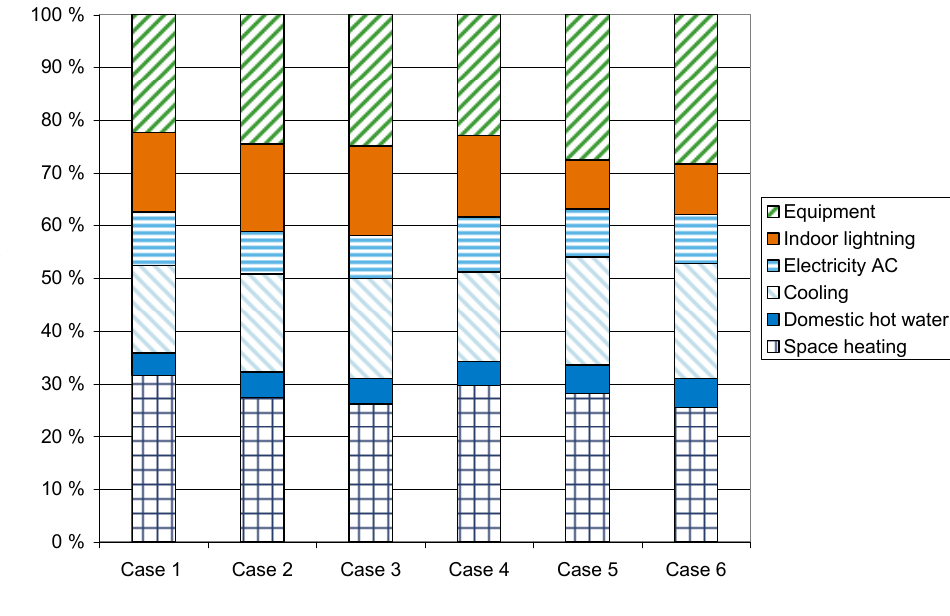
Figure 2. The share of different energy use in different cases.